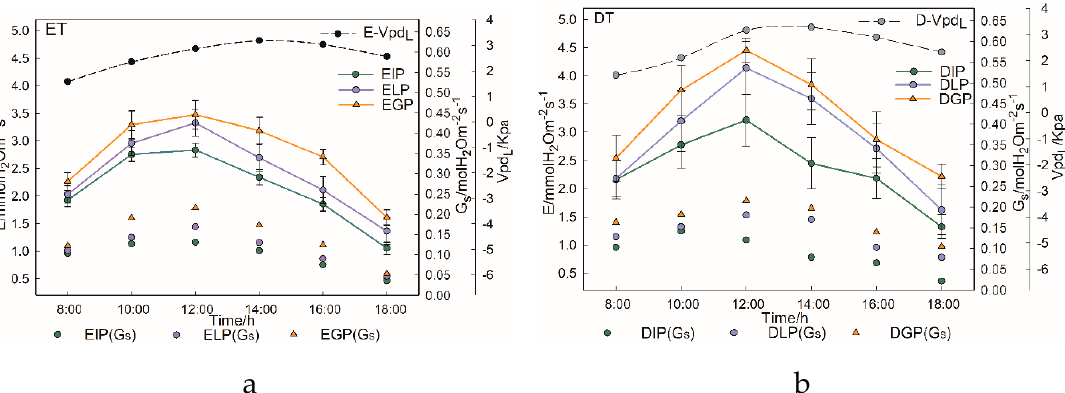
a b Figure 6. Daily variations of E, G s , and Vpd L of evergreen tree species (ET) and deciduous tree species (DT) in three configuration modes. Transpiration rate (E); stomatal conductance (G s ); vapor pressure deficit (Vpd L ); individual planting of evergreen (EIP); linear planting of evergreen (ELP); group planting of evergreen (EGP); individual planting of deciduous (DIP); linear planting of deciduous (DLP); group planting of deciduous (DGP). ( a ) Diurnal variations of E, G s , and Vpd L of ET in three configuration modes; ( b ) Diurnal variations of E, G s , and Vpd L of DT in three configuration modes.